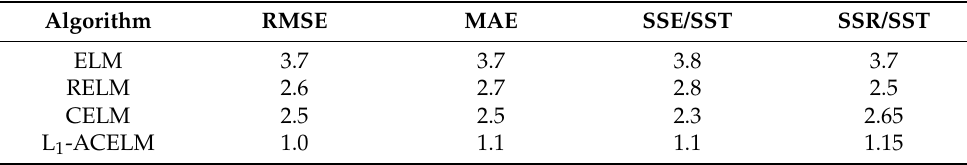
Table 8. Average ranks of benchmark algorithms under 5% noise environment.